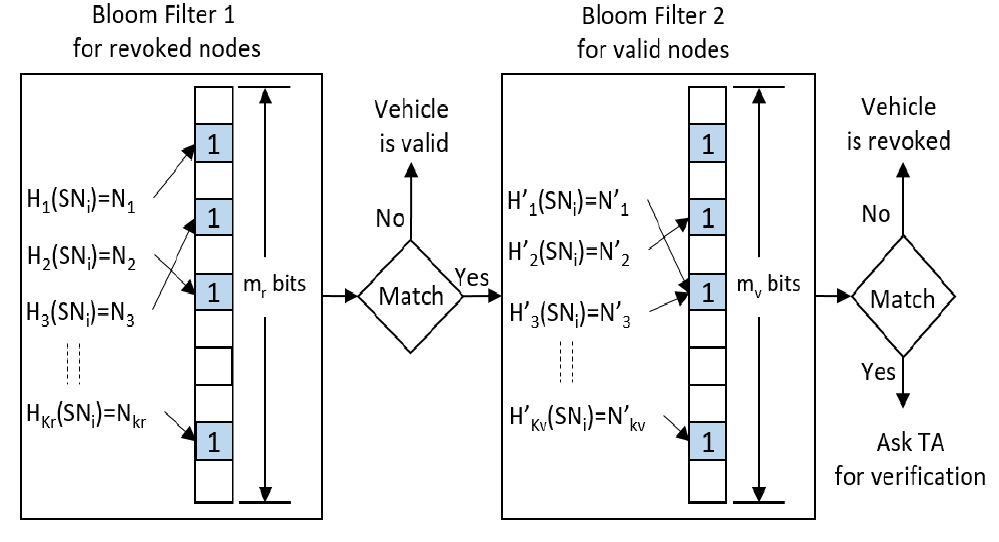
Figure 4. Two Bloom filters.